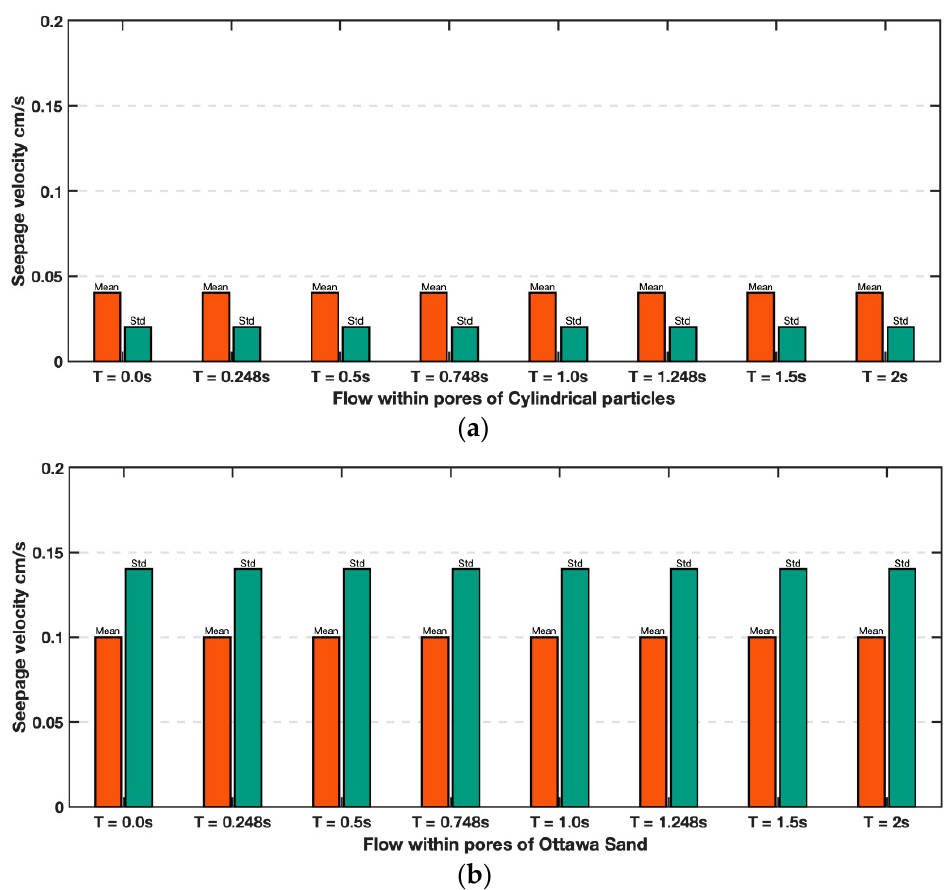
Figure 11. Comparison of mean interstitial flow velocities in 8 consecutive frames for flow between ( a ) Cylinders (top) and ( b ) simulated Ottawa sand particles (bottom).